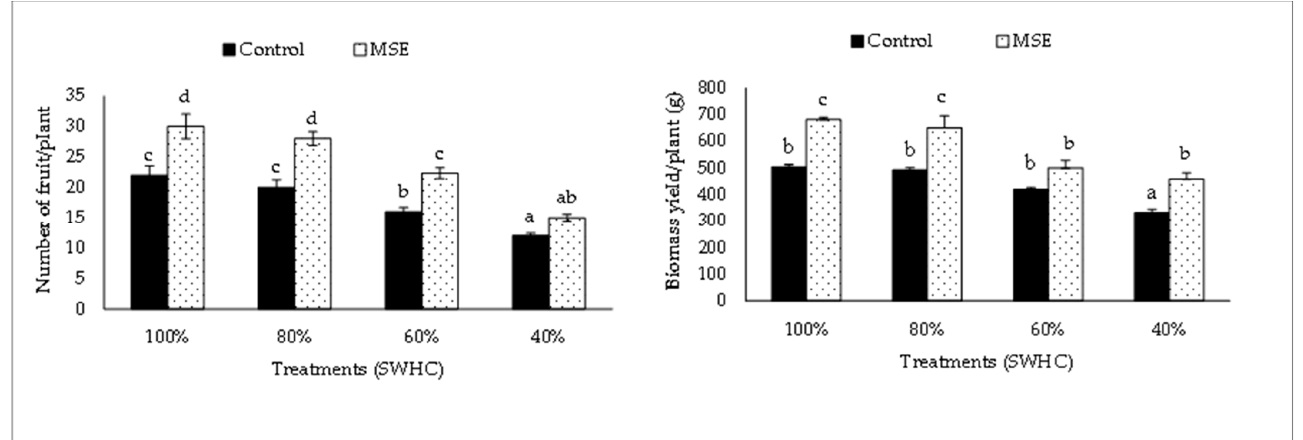
multiple range test.